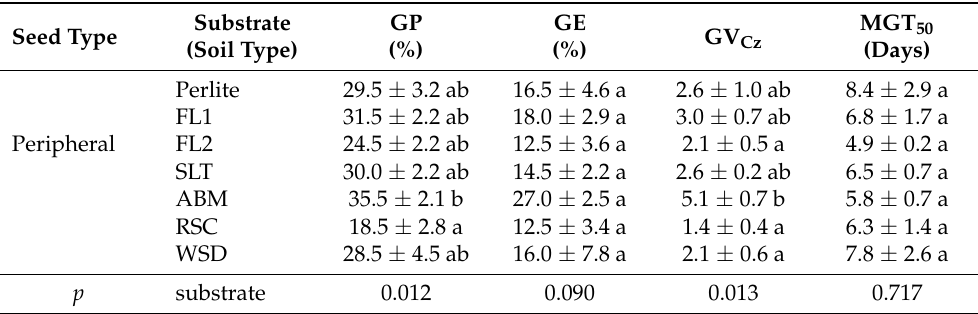
Table 5. Mean values ( ± SE) and significance level ( p ) of the germination parameters assessed on different substrates (soil types), in the greenhouse and under natural light, using peripheral seeds collected in June 2005.